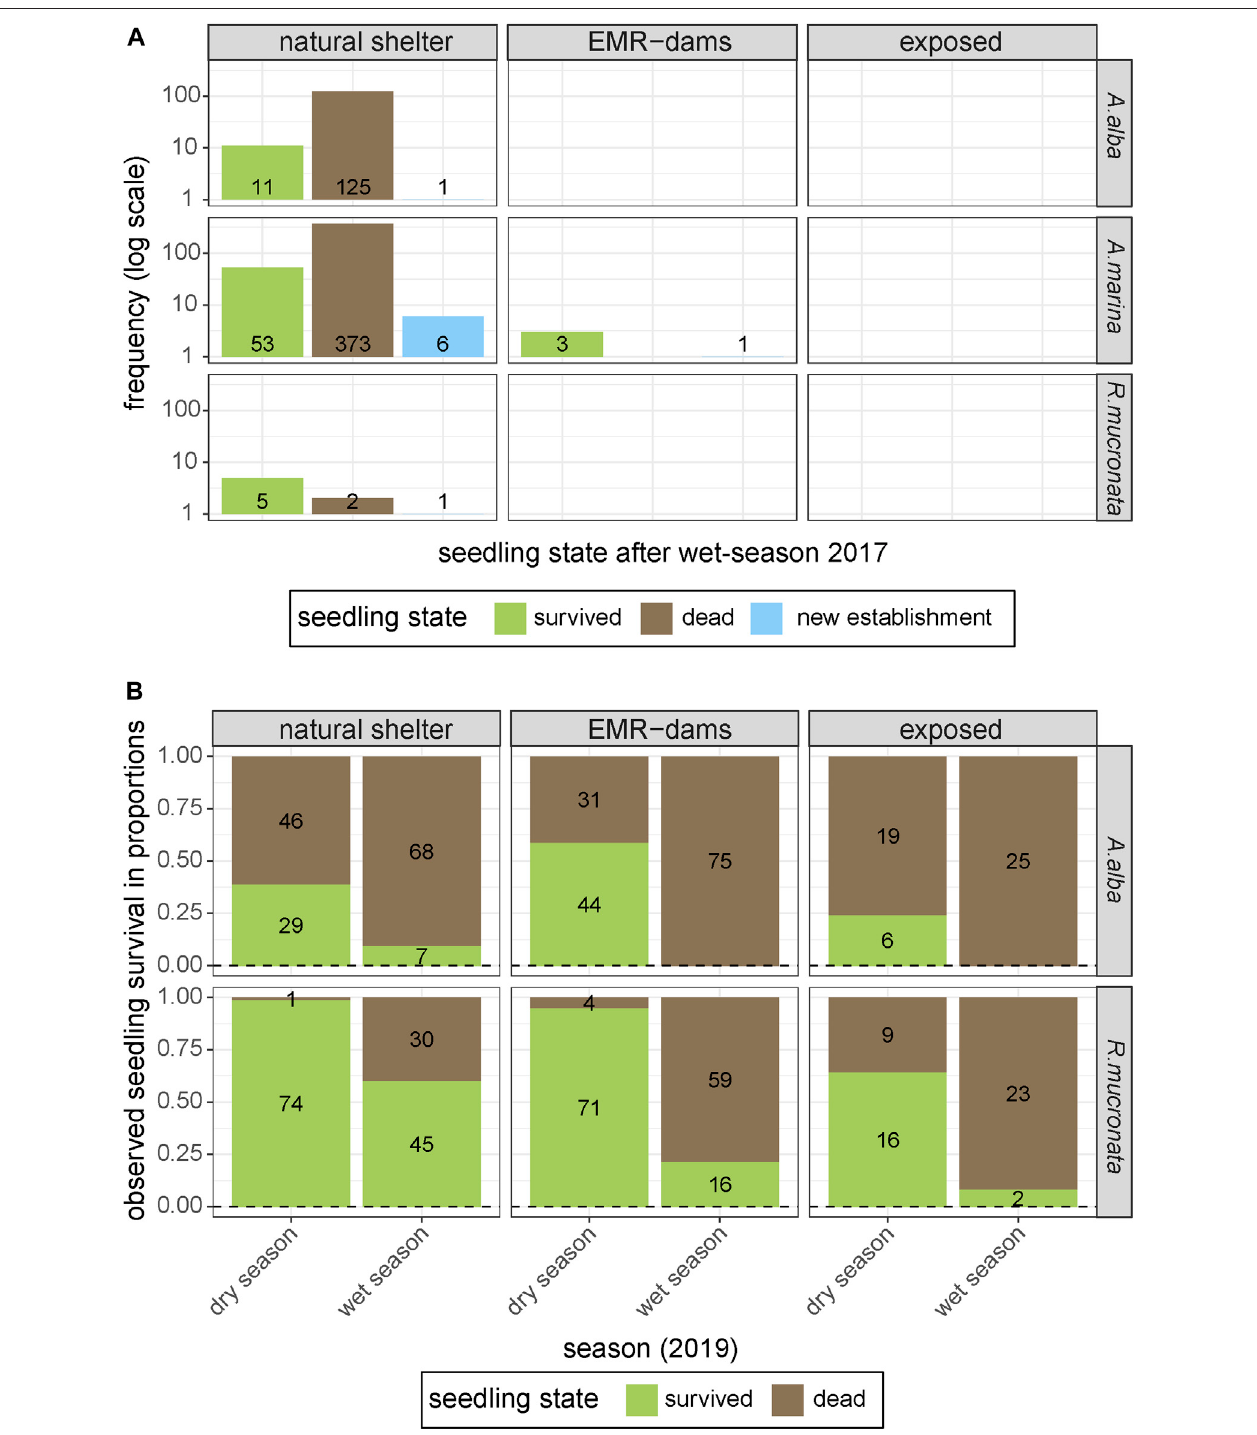
FIGURE 6 | (A) Existing and new natural establishment of mangrove seedlings at the three differently sheltered coastal sites above MSL [natural shelter, arti fi cial shelter(EMR),andwave-exposed],andsurvivalofexistingnaturalrecruitsoverthecourseoftheexperiment. (B) Survivalof A.alba and R.mucronata seedlingsthatwere planted at naturally sheltered sites, at habitat restoration sites behind an EMR-dam, and at an exposed site.